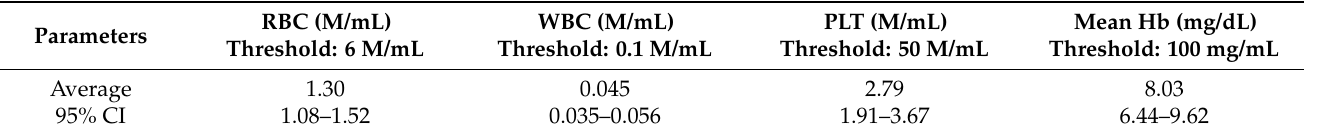
Table 4. Average blood cell count and hemoglobin concentration in plasma from the ZDiscs. RBC: Red Blood Cell; WBC: White Blood Cell; PLT: Platelet; CI: Confidence